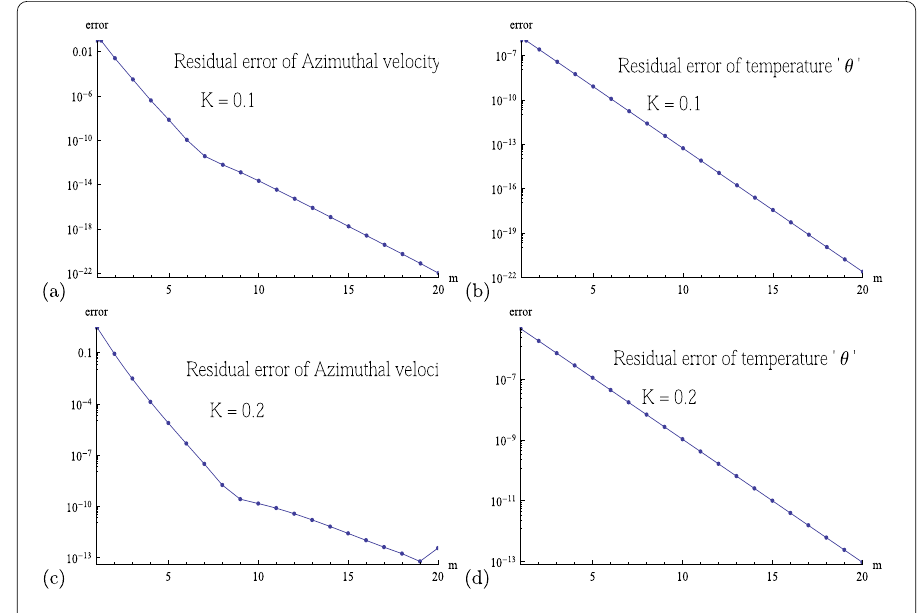
Figure 4 Residual error using 20th-order (HAM) via Mathematica package BVPh2.0 approximation, where Ma = 1, M = 1, ϒ = 0.127013, Pr = 0.2, Gr = 5 and S = 0.2.